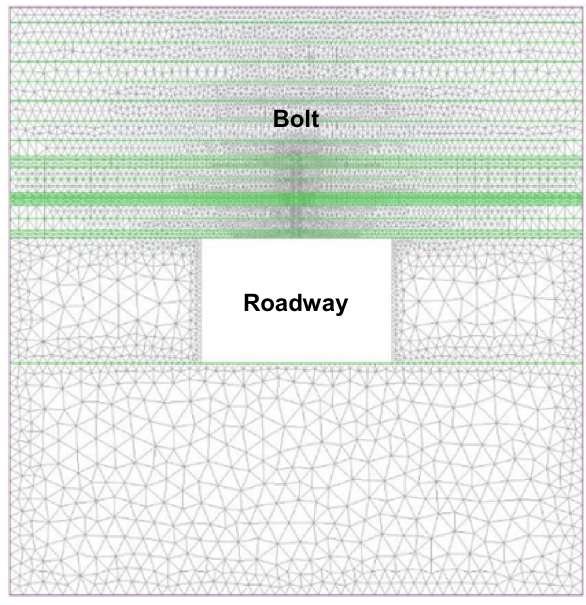
Fig. 1 Finite element mesh with RS 2 . Green lines represent material boundaries used to differentiate various stratigraphic layers used in this